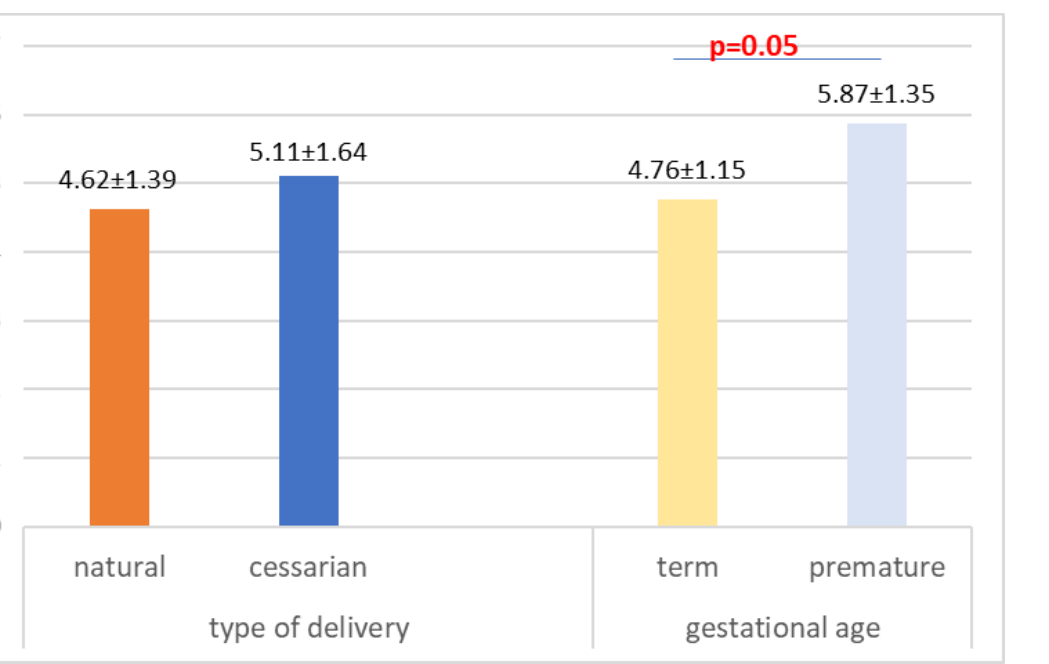
Figure 2. Distribution of patients according to duration of calming down .